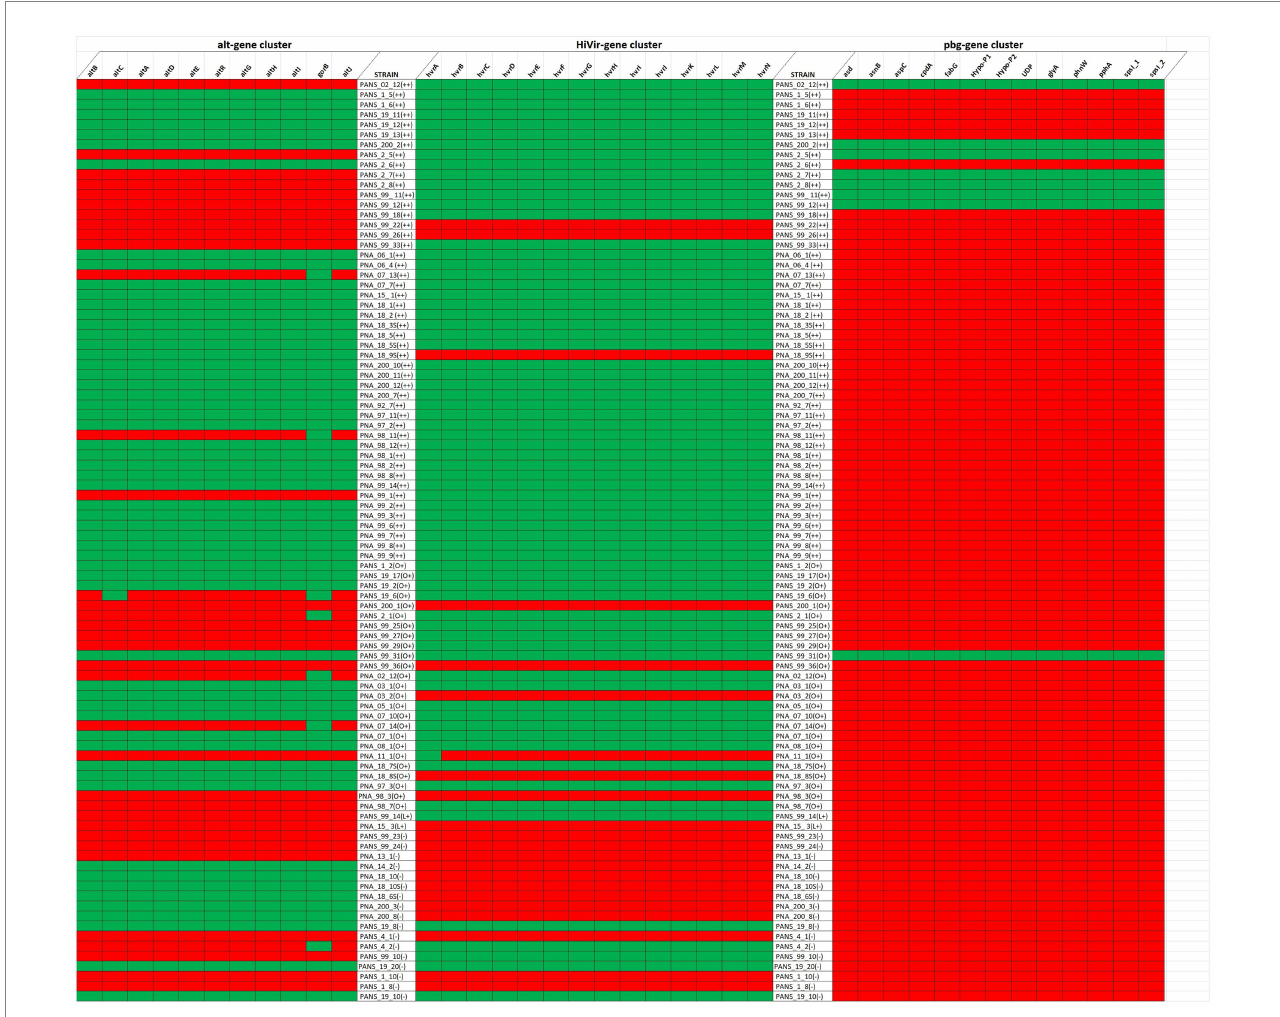
FIGURE 8 Presence and absence of the Alt (left), HiVir (middle), and the pgb cluster (right) genes within the genome of Pantoea ananatis based on their foliar pathogenicity on Allium porrum (cv. King Richard) and A. fistulosum × A. cepa (cv. Guardsman). Green and red represent presence and absence of gene, respectively for each gene cluster evaluated. The foliar pathogenicity phenotype and associated aggressiveness is represented as “++” if the strain is pathogenic on both hosts, “L+” if pathogenic only on A. porrum , “O+” if pathogenic only on A. cepa × A. fistulosum , and “–” if pathogenic on neither